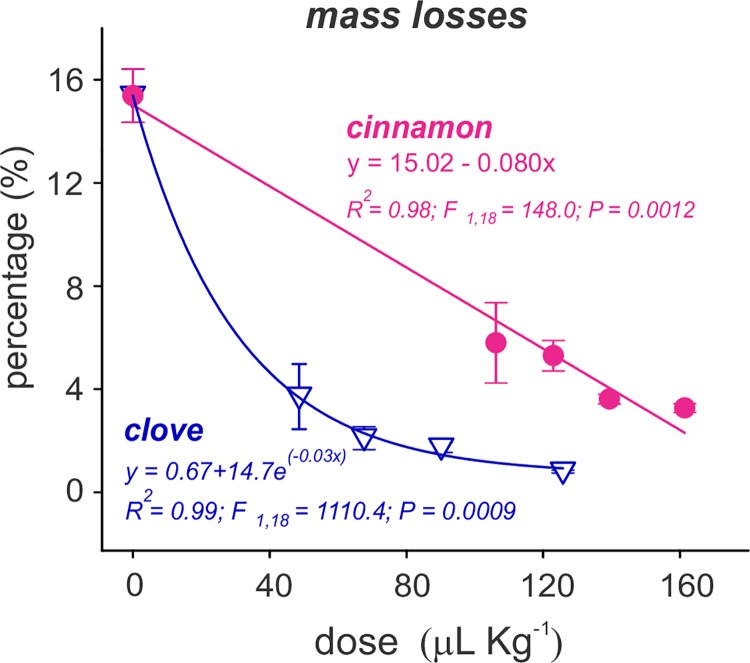
Bean weight losses caused by C. maculatus exposed to clove and cinnamon essential oils.The symbols represent the means of five replicates of the LD0 (control), LD20, LD40, LD60 and LD80 for each oil. The doses are expressed in μL of essential oil/kg beans. The vertical bars represent the SD.